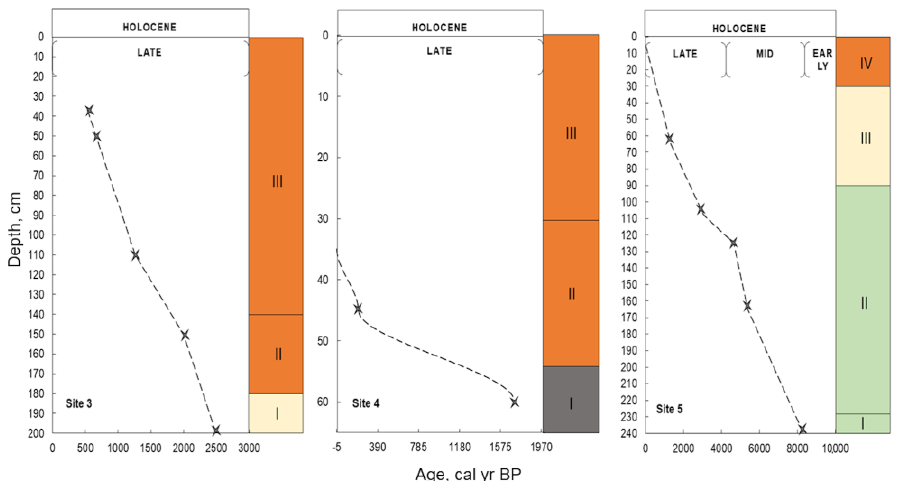
Figure 10. Peat accumulation rate reconstructed from radiocarbon dates within different stages of the Holocene (KRA). The color scale shows the stages of bogs ’ genesis: ombrotrophic (orange), transitional (yellow), minerotrophic (green), pyrogenic horizon (gray). I-IV correspond to the paleo-communities from Figures 6 – 8. Stars represent peat sampling depths.